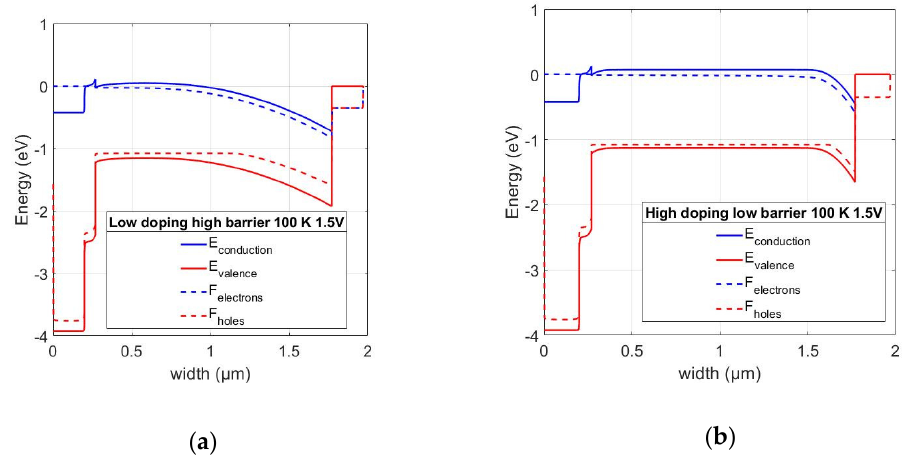
Figure 11. Simulated band diagrams at 100 K, a bias of 1.5 V and a transparency of 100% ( a ) for the low-doping high-barrier case and ( b ) for the high-doping low-barrier case. An absorber thickness of 1.5 µm is defined in both cases.